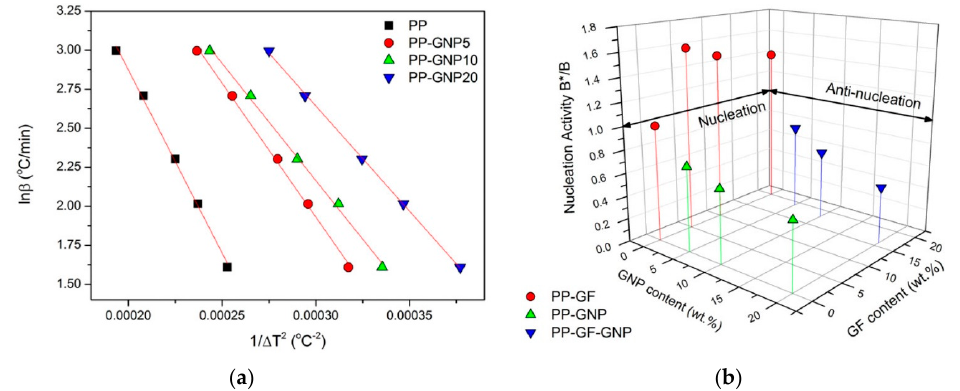
Figure 8. ( a ) Dobreva plots for the evaluation of the nucleation activity of PP-GNP composites. ( b ) 3D plot for the calculated B*/B ratio from Dobreva’s method.